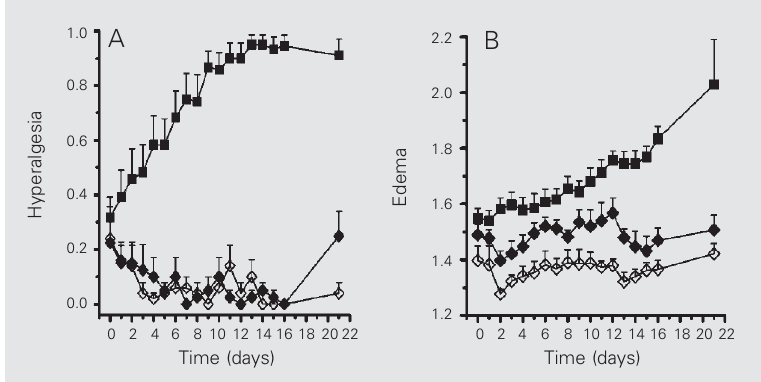
Figure 3. Effect of dexamethasone on the hyperalgesia (A) and edema (B) of adrenalecto- mized old arthritic rats (filled squares). Dexamethasone 0.1 (open lozenges) or 0.01 mg/kg (filled lozenges) was administered by gavage daily starting immediately after surgery, 5 days before induction of arthritis, and continued until the last day of the experiment. N = 4- 5/group. See legend to Figure 1 for a description of the induction of arthritis.